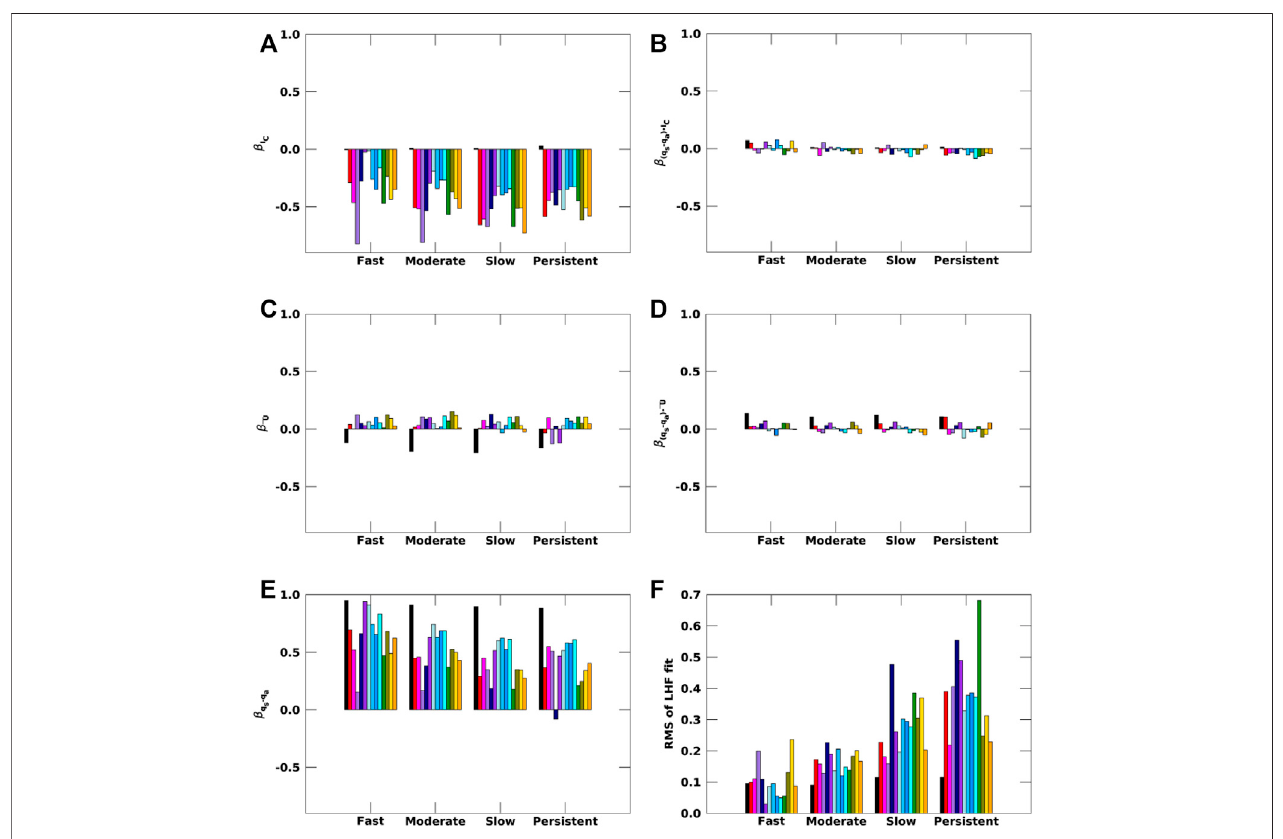
FIGURE9| Slopesobtainedfromthemulti-linearregressiononLHF (A – E) forobservations(black)andCMIP6models(colored)forthefouricelossregimesduring Arctic winter (ONDJ). RMS for the fi t is shown in (F) .